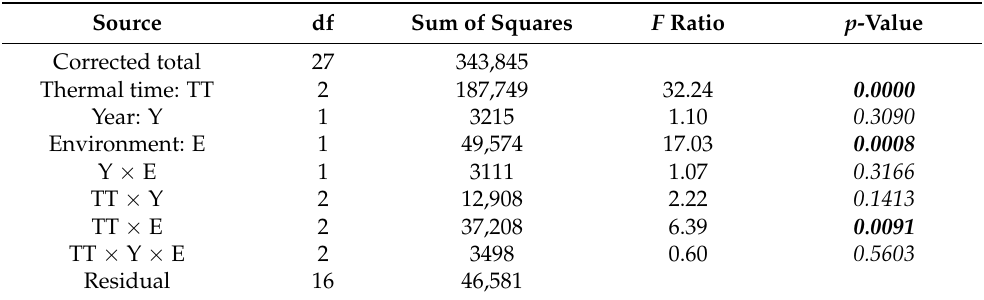
Figure 3. Anthocyanin content during grain filling for two seasons (2017 and 2018) and for the purple barley genotype (Hindukusch) under control conditions (blue circles) and thermal stress (red triangles). Solid lines represent the best fit (second-degree polynomial curve, Total R 2 = 86.45%) for control ( blue ) and stressed ( red ) conditions, respectively. Table 4. Analysis of variance for anthocyanin content ( µ g Cy-3-glu/g) according to a second-degree curve for thermal